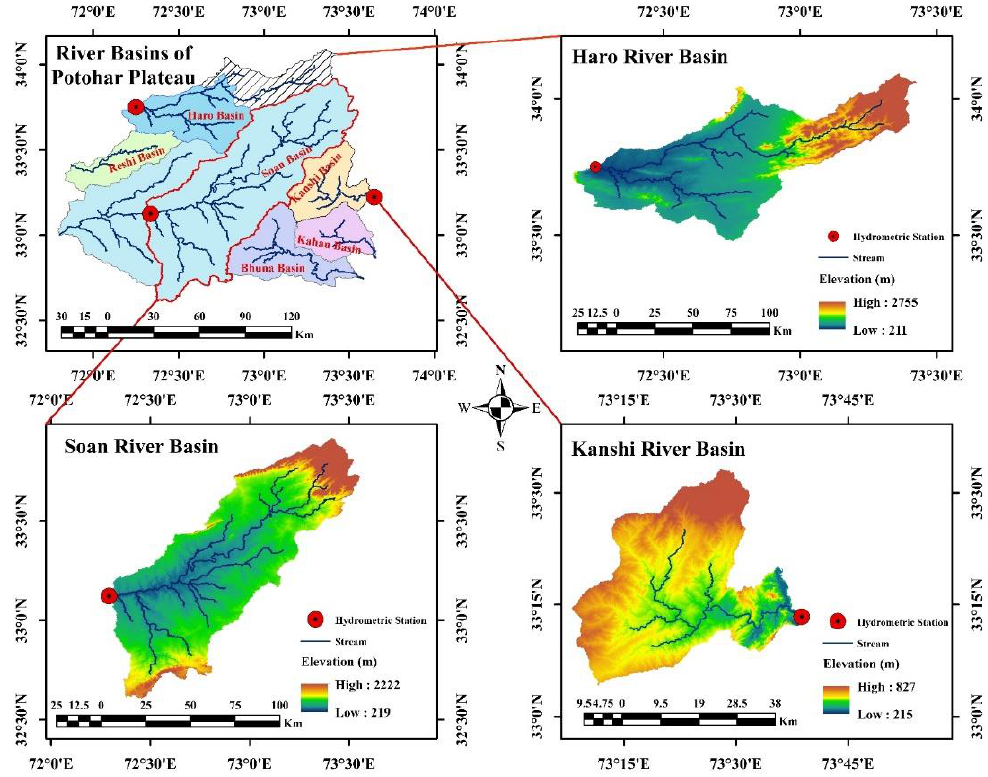
Figure 2. Delineated watersheds of Potohar Plateau with hydrometric stations.